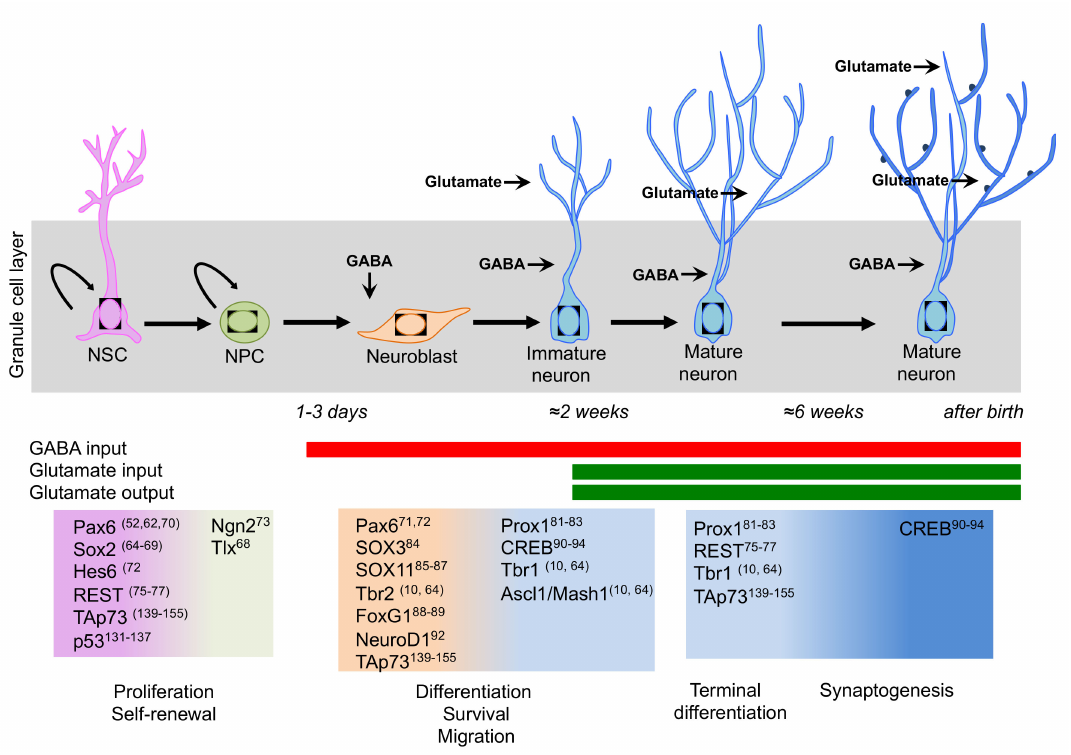
Figure 2. Schematic representation of the transcription factor network involved in neurogenesis in the adult hippocampus. A sequential and coordinated expression pattern of the neurogenic transcription factors is fundamental for the proper progression from neural stem cells (NSCs) to mature neurons (Please see main text for details). During neurogenesis, a switch takes place from GABA excitatory to GABA inhibitory and glutamate excitatory